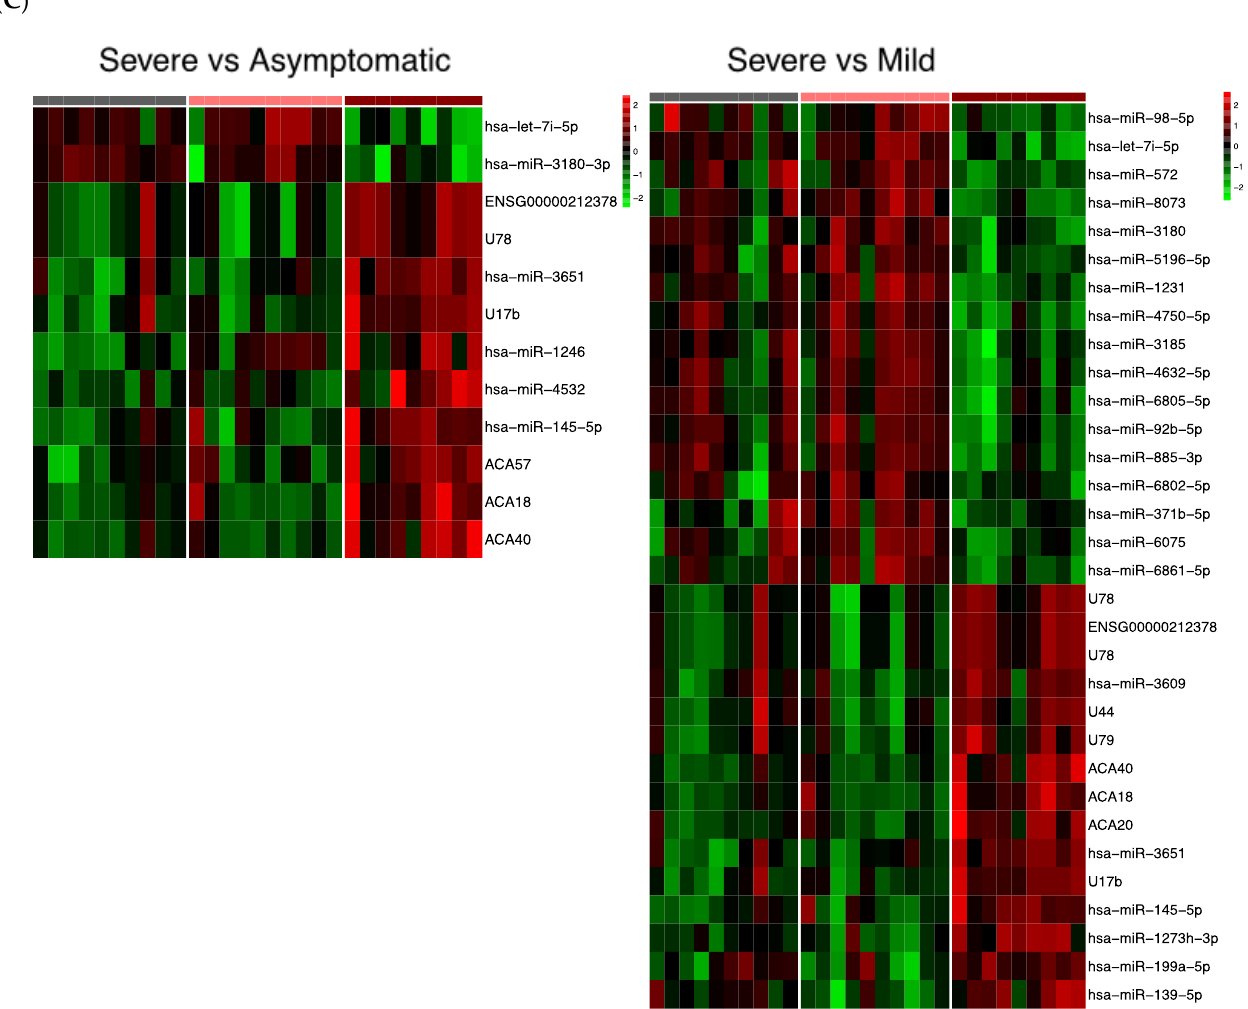
Figure 1. Differential expression analysis of miRNAs and snoRNAs in asymptomatic, mild, and severe COVID-19 patients. ( A ) A Venn diagram of the number of unique and common differentially expressed miRNAs and snoRNAs in severe versus asymptomatic (D: grey: upregulated, A: orange: downregulated), and in severe versus mild (C: purple: upregulated, B: green: downregulated). The overlap of the two ovals with upregulated transcripts represents 7 miRNAs and snoRNAs shared between the two upregulated lists, and the two ovals with downregulated transcripts represent 1 miRNA shared between the two downregulated lists. The areas of no overlap represent the number of uniquely (not shared) miRNAs/snoRNAs in each respective comparison, namely 4 in severe versus asymptomatic, and 23 miRNAs/snoRNAs in severe versus mild comparison. ( B ) Volcano plots of differentially expressed miRNAs and snoRNAs, with y-axis as-log 10 adjusted p -value (adjusted for multiple testing with the Benjamini–Hochberg procedure) and x-axis as the log 2 -fold change. The vertical lines represent a threshold of |log 2 -fold change| > 1.5, either upregulated (right side) or downregulated (left side), while the horizontal lines represent an FDR < 0.05. Each colored point represents an individual probe in severe versus asymptomatic comparison (D: green: upregulated, A: orange: downregulated), and in severe versus mild comparison (C: purple: upregulated, B: grey: downregulated). ( C ) Hierarchical clustering of Log 2 normalized expression values of the differentially expressed miRNAs and snoRNAs in severe versus asymptomatic comparison (n = 25), and in severe versus mild (n = 50).